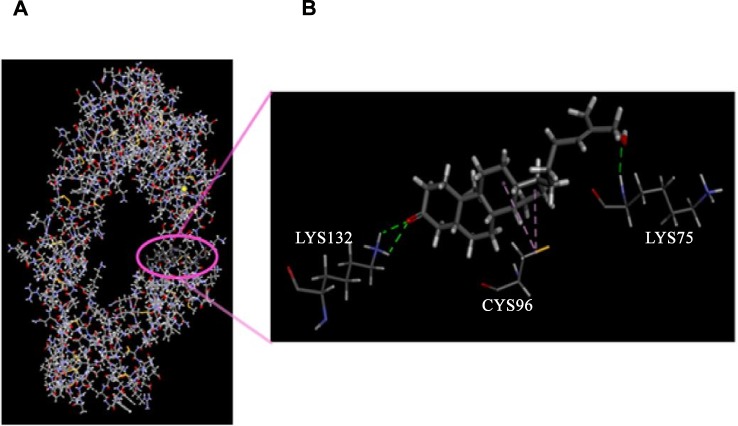
Molecular docking of the cycloartane (circle) onto TNF-R1.Magnification showing hydrogen bonding (green dashed lines) between hydroxyl and carbonyl groups of the compound with lysine-75 and -132 and hydrophobic interactions (purple dashed lines) between the cyclohexane and cyclopentane of the compound with cysteine-96 of the receptor.